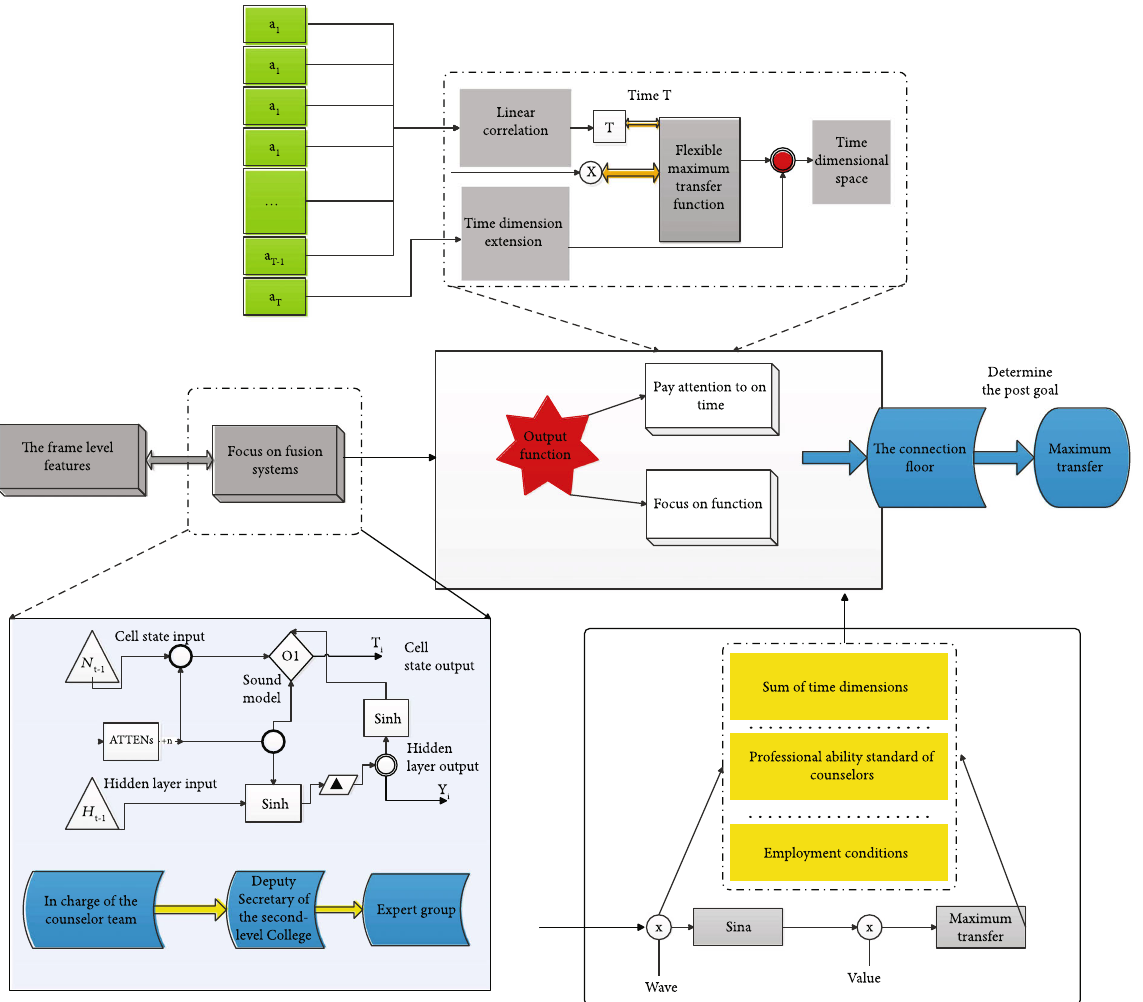
Figure 1: Integrating Attention-LSTM, time dimension AI attention, and feature dimension AI attention algorithm